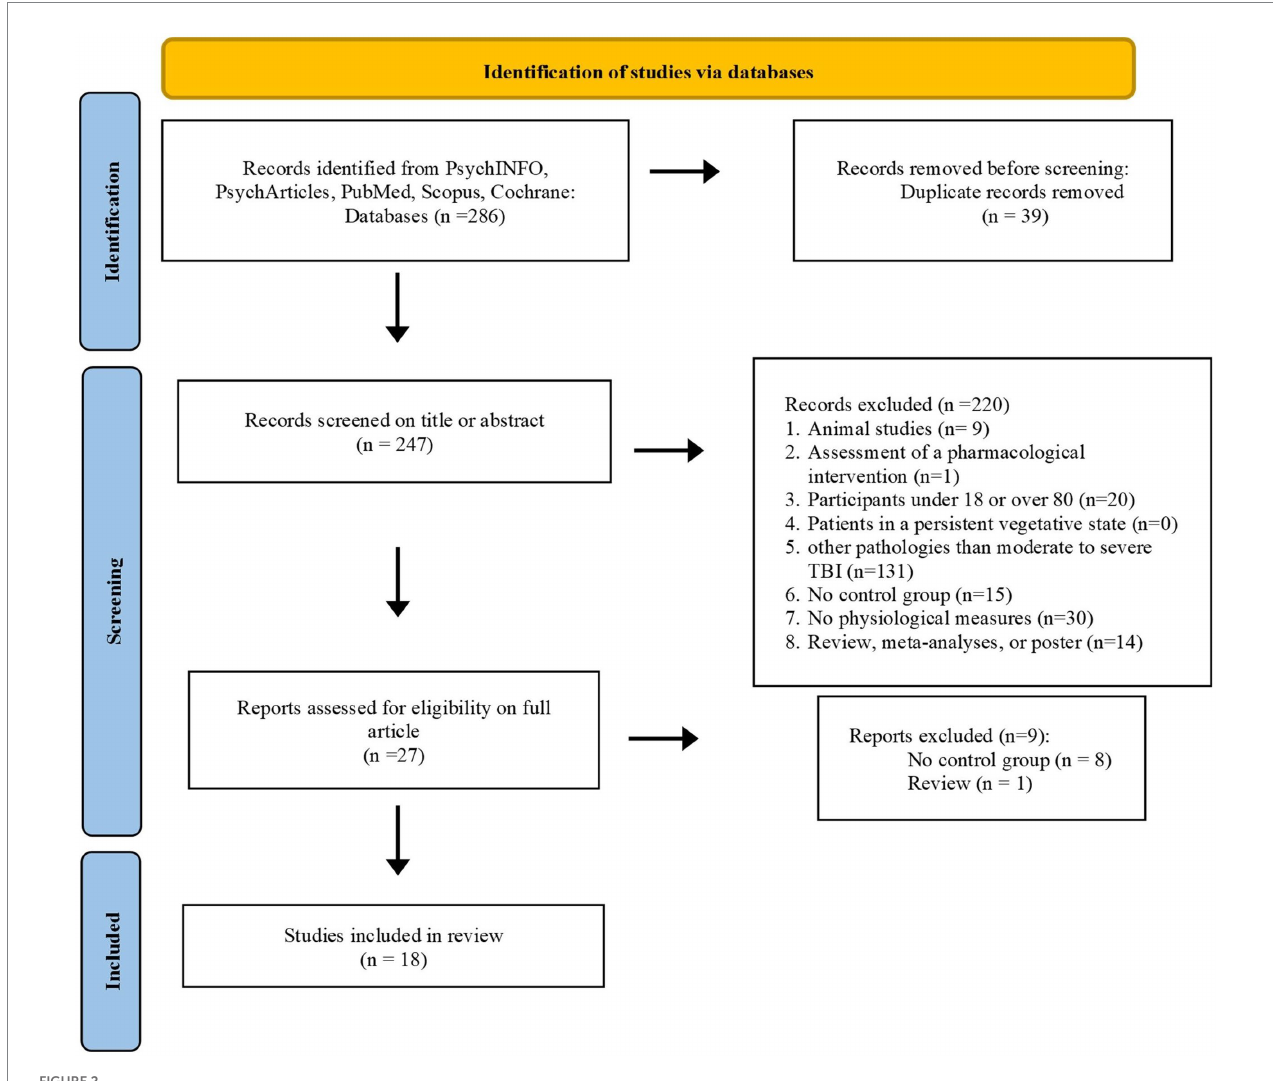
FIGURE 2 Flow diagram showing inclusion/exclusion of studies identified during database search